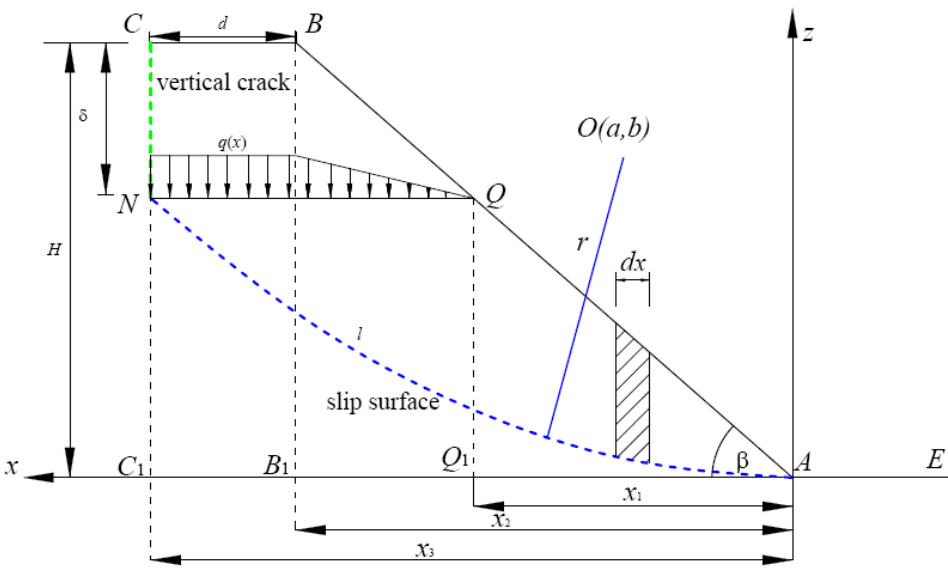
Figure 3. Toe circle slope calculated model.